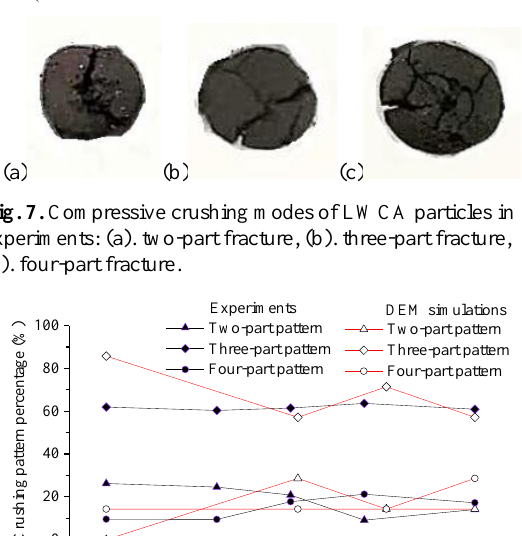
Fig. 6. Normalized survival curves with different particle sizes ( d = 2.0-3.0 mm).